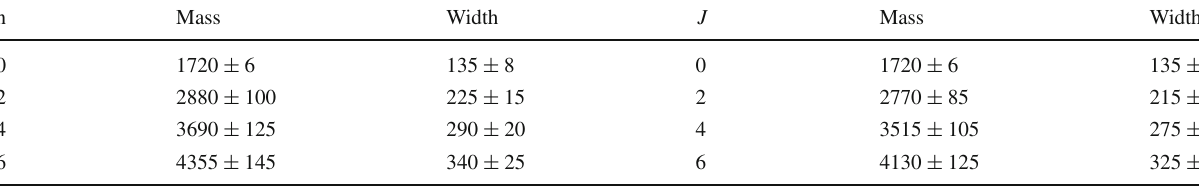
Table 9 Predictions using linear trajectories with glueball slope using f 0 ( 1710 ) as the ground state